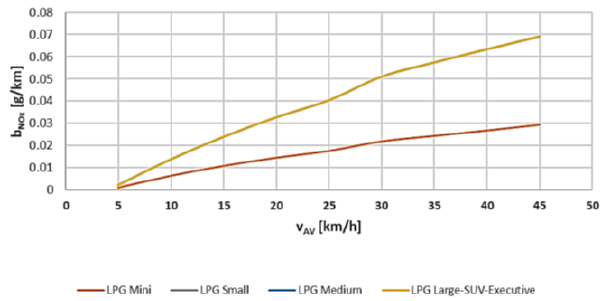
Fig. 17. NO x emission from LPG PCs for vehicle segments depending on average speed